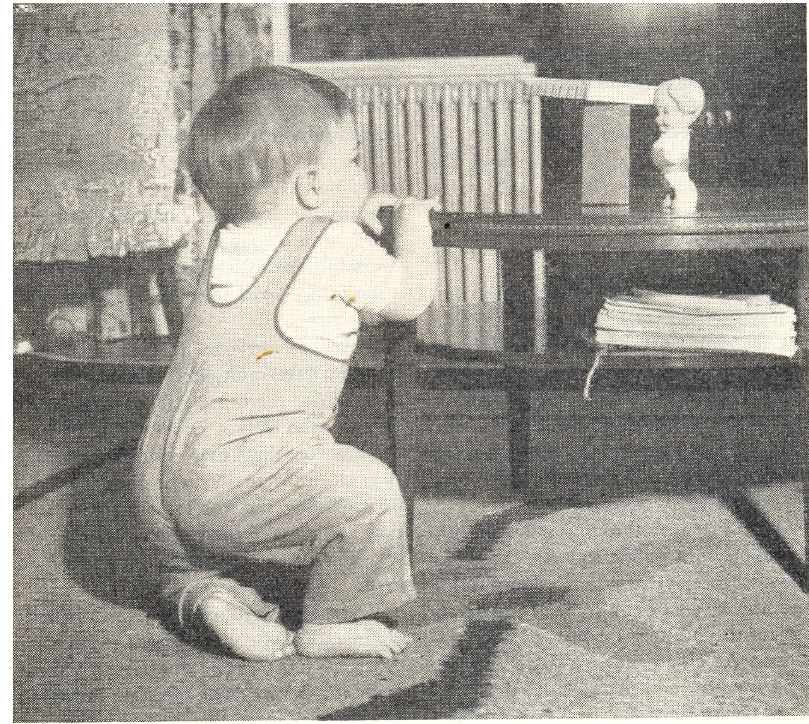
Figure 26. Baby’s Job is Exploring the Environment. While earlier experts advised against bath toys as a distraction, the 1951 Infant Care pamphlet described bath time as a pleasurable activity, as seen in Figure 27.